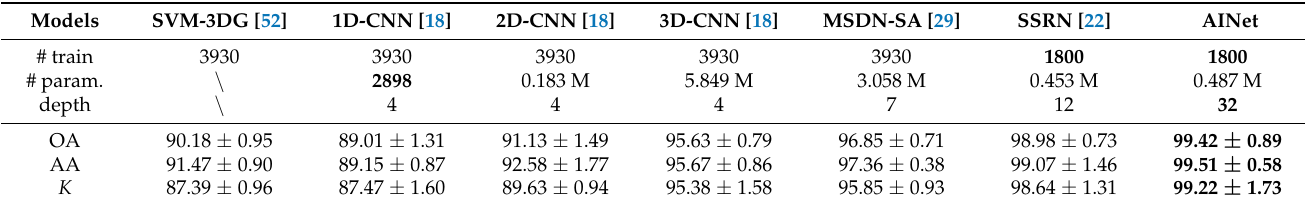
Table 6. Classification results for the Pavia University dataset.